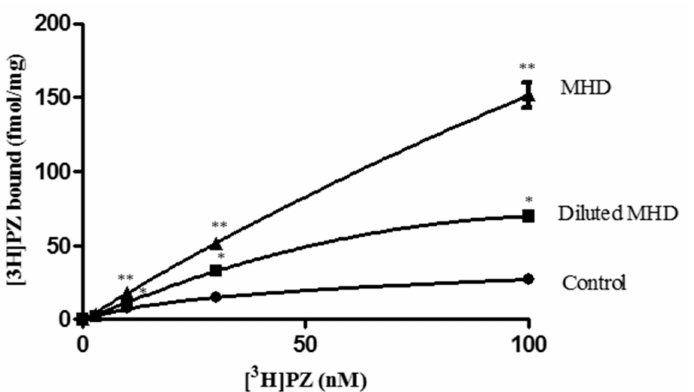
Figure 5. Total binding of [ 3 H]PZ to muscarinic AChRs without and with 30 µ L MHD, and 30 µ L of 1:5 diluted MHD. MHD dose independently increase the binding of [ 3 H]PZ. ** Significantly different from control and MHD. * Significantly different from control and diluted